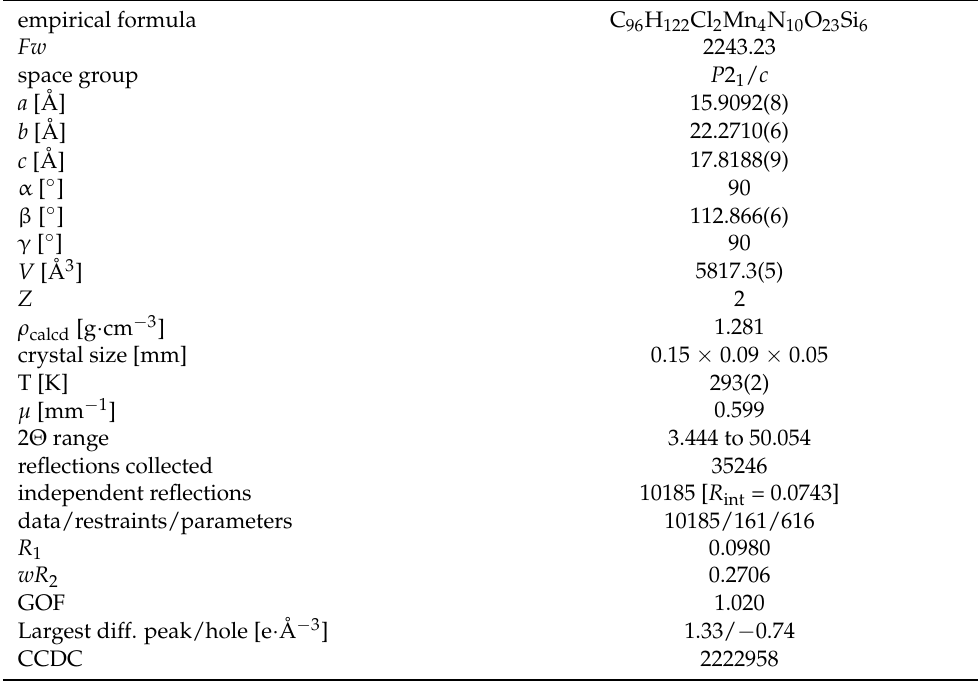
Table 1. The crystal data and details of the data collection process. empirical